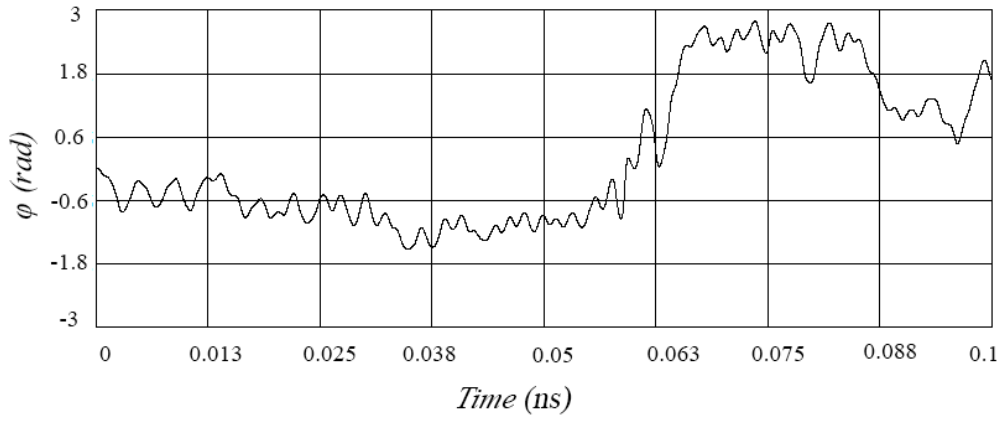
Figure 4. Angle of proper rotation of central fullerene.